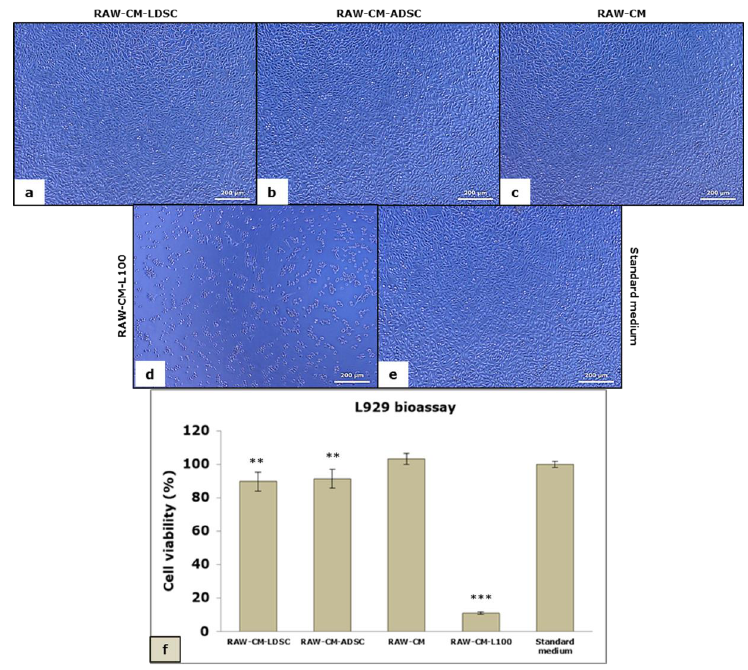
Figure 7. Morphology of L929 cells cultured for 24 h in conditioned media of RAW 264.7 macrophages previously cultured in LDSC-CM (RAW-CM-LDSC) ( a ), ADSC-CM (RAW-CM-ADSC) ( b ), standard medium for RAW cells (RAW-CM) ( c ), LPS-100 (RAW-CM-L100) ( d ) and standard medium for L929 cells ( e ); phase contrast with objective magnification 10x; viability of L929 cells in L929 bioassay evaluated by MTT test ( f ), mean ± standard deviation (SD); sample size: n(LDSCs) = 4 and n(ADSCs) = 4 (n − number of patients per group); for each patient sample culture-derived CM, as well as controls, four to eight replicates were analyzed; (**) p < 0.01, (***) p < 0.001 (compared to standard medium). Int. J. Mol. Sci. 2019 , 20 , x FOR PEER REVIEW